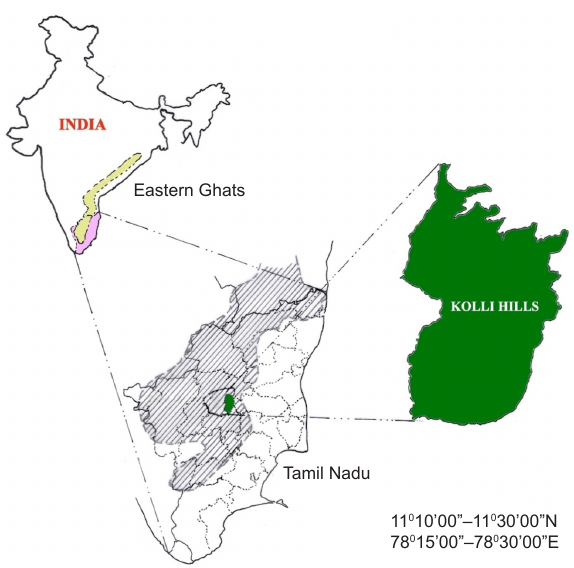
Figure 2. Clarkeinda trachodes a - habit; b - spores; c - basidia; d - pleurocystidia; e - pileal